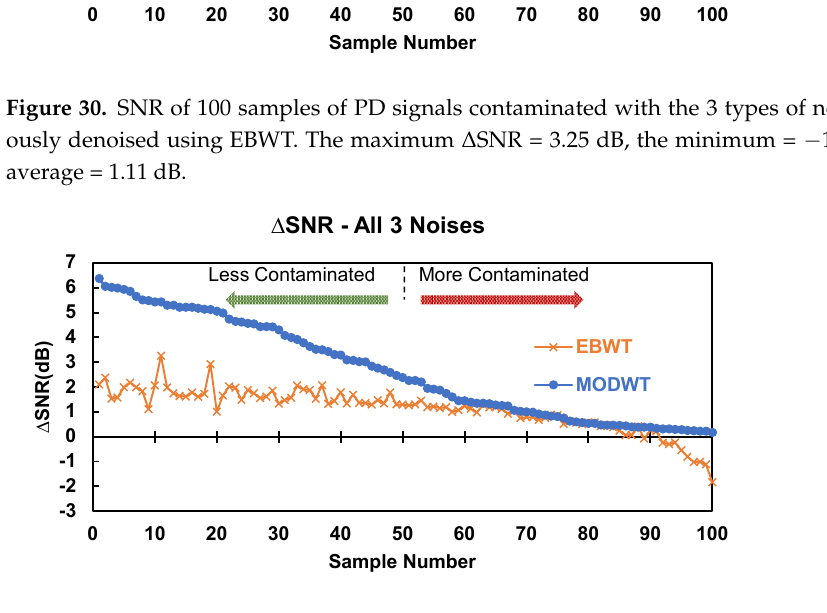
Figure 31. ∆ SNR for both MODWT and EBWT. For most cases, the MODWT achieved better results. As the signal becomes more noisy, the MODWT holds positive results, while the EBWT decreases the signal SNR. Average ∆ SNR for MODWT was 2.66 dB and for EBWT was 1.11 dB. The summary of the improvements in SNR values ( ∆ SNR) for all previous cases as well as the average values of NCC calculated for the same cases are displayed in Table 1. The matching trend between NCC and SNR values confirms the previous